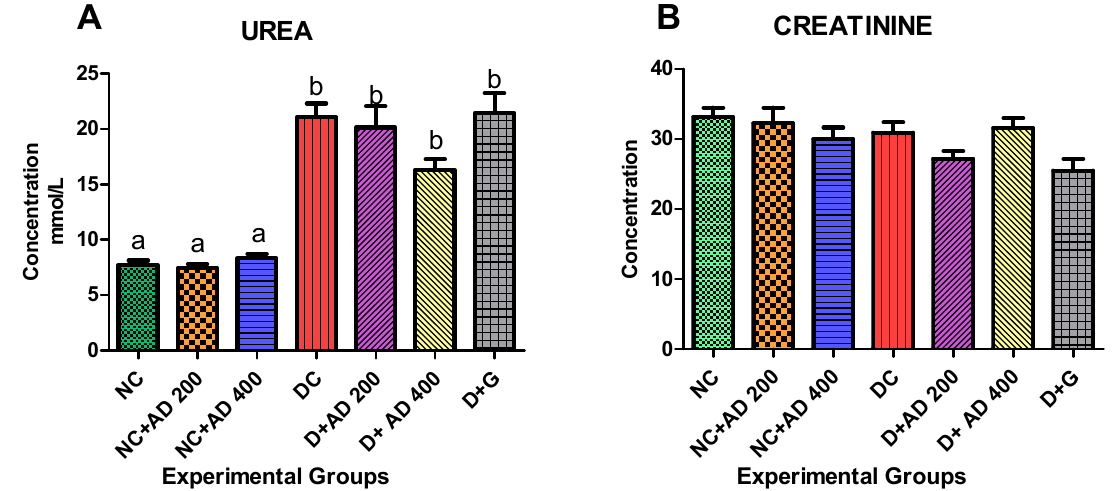
Figure 3. Effect of AD administration on the ( A ) urea and ( B ) creatinine concentration in the serum of normal and diabetic rats. Bars are indicative of mean values ± SEM group values. Bars with different letters are significantly ( p < 0.05) different from each